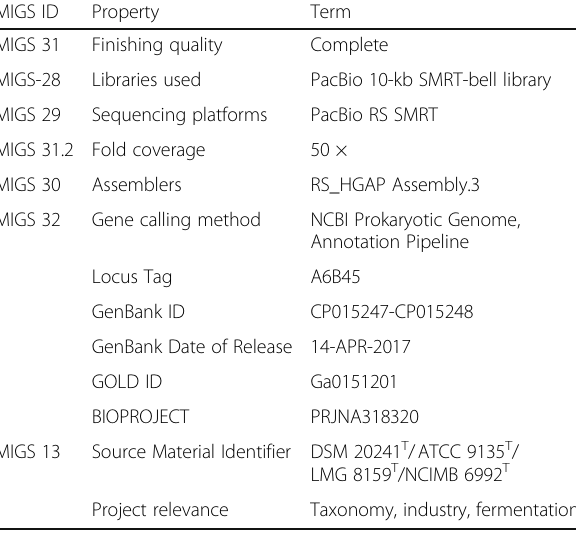
Table 2 Genome sequencing project information for Leuconostoc suionicum DSM 20241 T